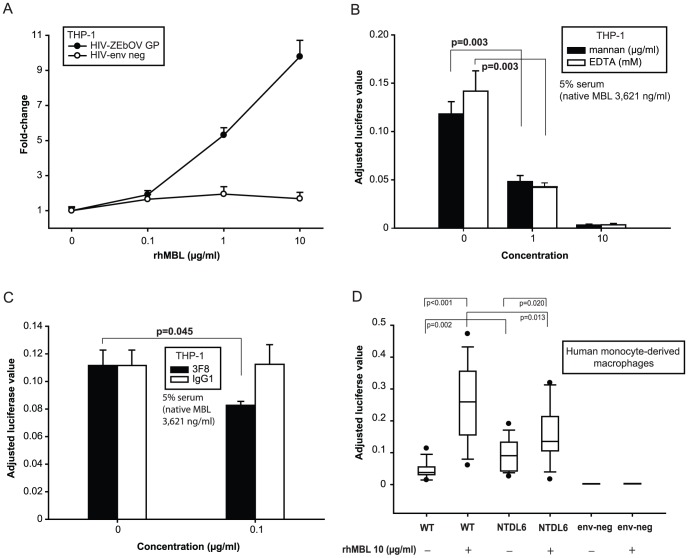
MBL enhances HIV-EBOV GP infection of THP-1 cells and human monocyte-derived macrophages.(A) We stimulated 5×104 THP-1 cells with PMA (10 ng/ml) and supplemented the cells with IL-4 (100 ng/ml) for 72 hours. We preincubated HIV-EBOV GP or HIV-env negative virion-like particles (1200 pg p24/100 µl) with or without rhMBL before infecting differentiated adherent THP-1 cells cultivated in 5% MBL-deficient serum. (B) We cultivated 2.5×105 PBMC derived from human single-donor buffy coat samples in RPMI-1640 with 10% FBS and stimulated the cells with M-CSF (50 ng/ml) to induce differentiation of monocyte-derived macrophages. We infected cells with HIV-EBOV GP (WT), HIV-EBOV-ΔGP NTDL6 (NTDL6, mutated GP lacks 217 amino acids in the heavily glycosylated mucin-rich region) or HIV-env negative (env neg) in the presence or absence of rhMBL. The box plot represents outliers (dots), 10th and 90th percentiles (whiskers), 25th and 75th percentiles (box) and median values (line). Significant differences in infection rates are shown. Luciferase values were adjusted for cell viability using alamarBlue (resazurin reduction assay) for all the above experiments, which were performed twice in quadruplicate.